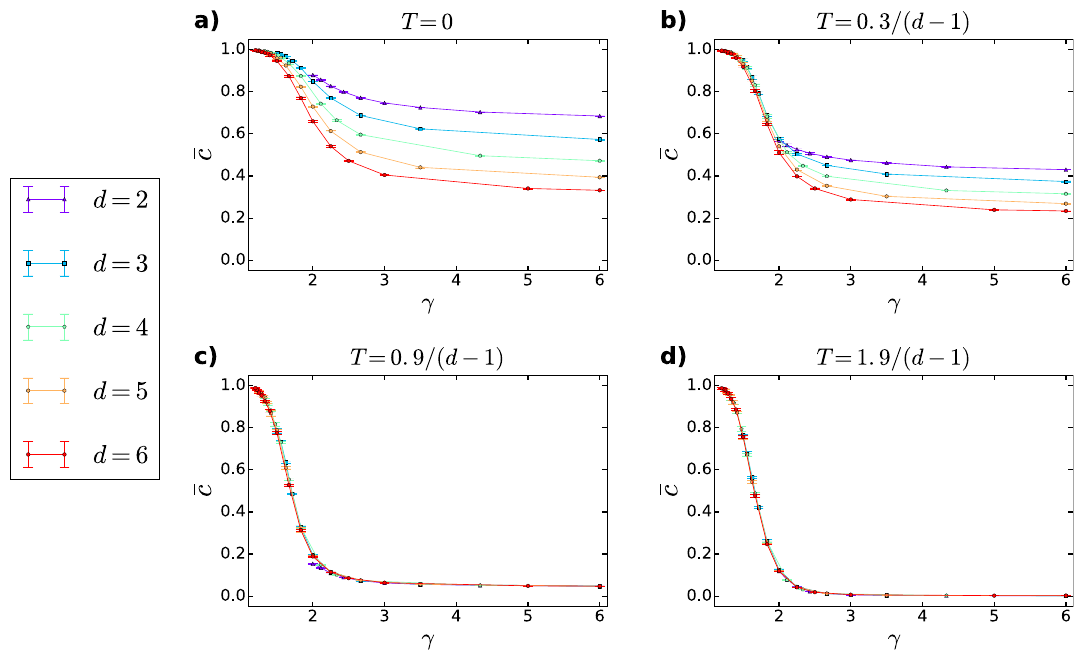
c measured in d -dimensional PSO networks as a function of the degree Figure 4. Average clustering coefficient ¯ decay exponent γ at different values of the temperature T and the dimension d . We plotted the average clustering coefficient averaged over 5 networks for each parameter setting, with the error bars indicating the standard 10, 000 , the expected average degree was deviations among the 5 networks. The size of the networks was N = k 2 m 10 , and each network was generated in a hyperbolic space of curvature K 1 . The curves of ¯ = = = − different colours correspond to different values of the dimension d of the hyperbolic space, listed in the legend. 1 The popularity fading parameter was always set to β 1 ) 1 ) . The different panels a – d were created using ( d (γ = − · − different values of the temperature T , specified in the panel 2 = is certainly increasing our freedom in the choice of the model parameters in general.